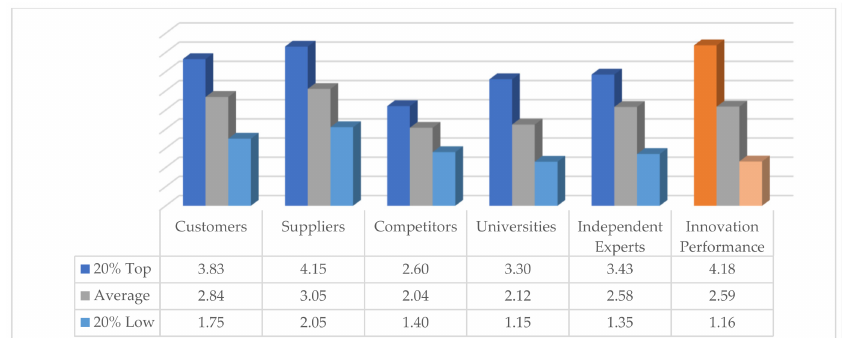
Figure 9. Comparative study of companies with the best and worst